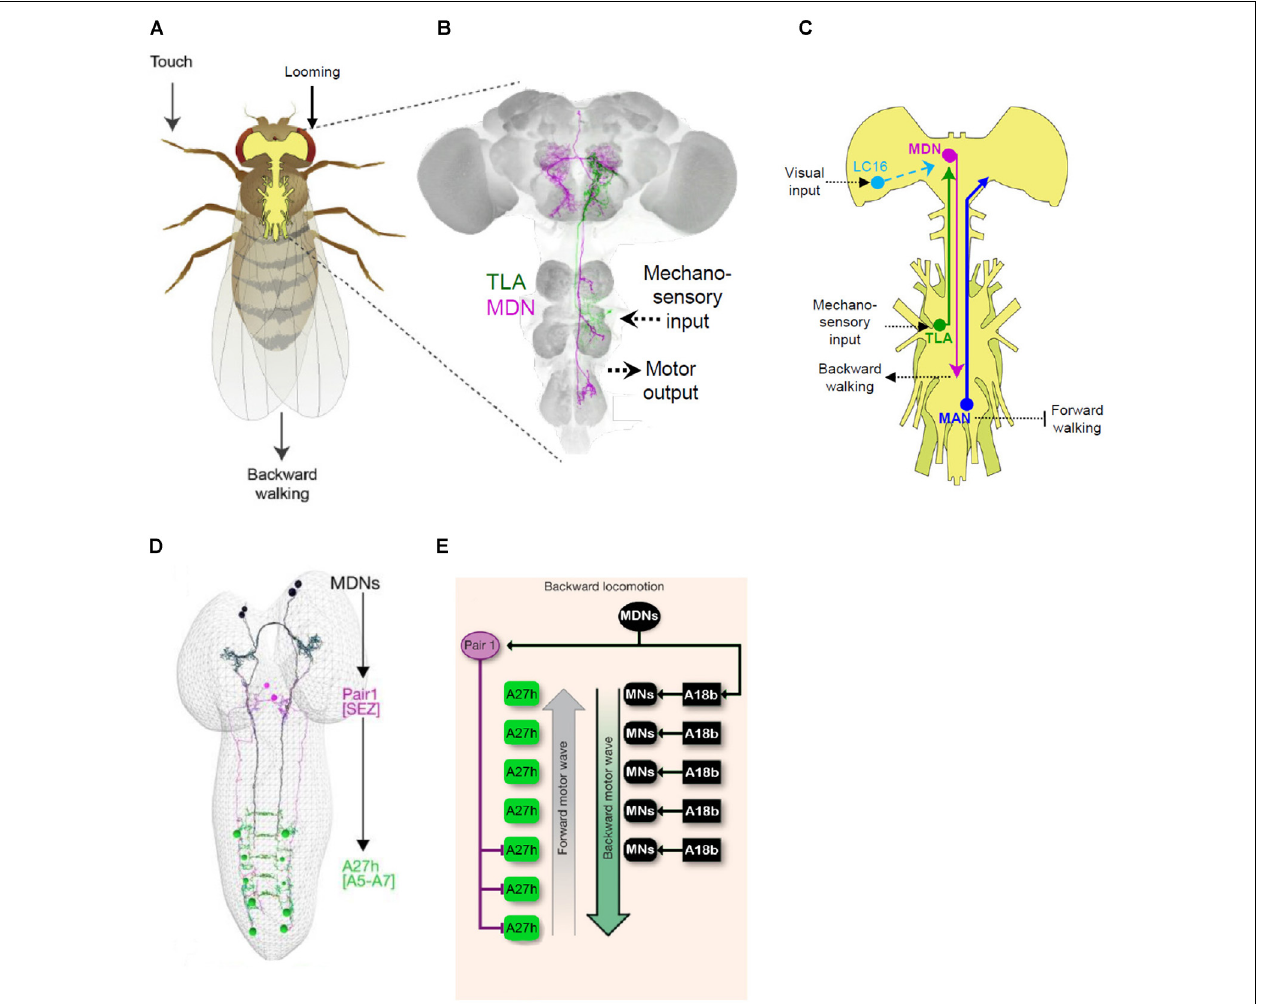
FIGURE 6 | Mapping behavioral circuits using Split Gal4. (A) Backwards walking (“moonwalking”) in adult Drosophila can be evoked by both mechanosensory and visual stimuli. (B) Two distinct neurons identified by Split Gal4 methods mediate reversal of walking direction: “Moonwalker Descending Neurons” (MDN, magenta) and “Two Lumps Walking Ascending Neurons (TLA, green). (C) Schematic showing the circuitry governing backward walking deduced from several Split Gal4 studies. In addition to the MDN and TLA, essential neurons in the circuit include lobula columnar (LC16) and mechanosensory neurons (TLA), which are sensitive to looming stimuli and touch, respectively, and the “Moonwalker Ascending Neurons” (MAN), which suppress forward walking. (D) Split Gal4 screening to find neurons involved in backward crawling also identified the MDNs (black). Connectomics analysis revealed that a major target of the larval MDNs is a pair of GABAergic neurons in the SEZ, “Pair1” (magenta), which inhibit posterior A27 h premotor neurons (green) required for forward crawling. (E) Schematic showing the larval circuitry responsible for backward crawling (i.e., “mooncrawling”). Panels (A–C) adapted from Sen et al. (2019); panels (D,E) from Carreira-Rosario et al.